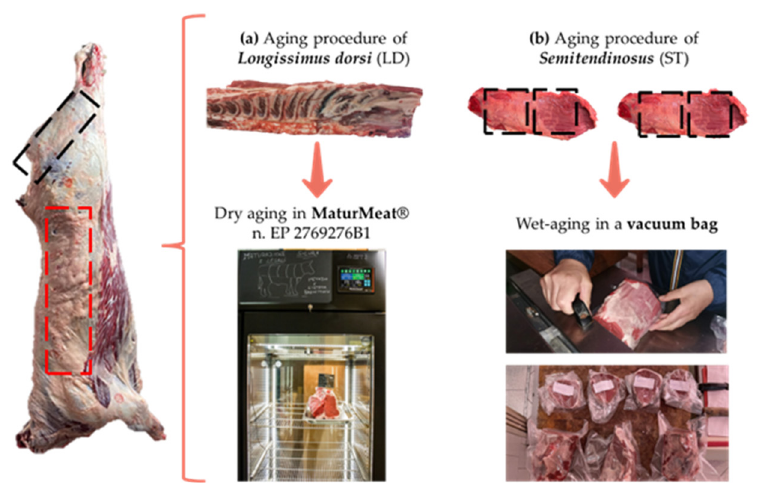
Figure 1. The schematic figures illustrate the dry ‐ aging ( a ) and wet ‐ aging ( b ) procedures of the bo ‐ vine muscles Longissimus dorsi (LD) and Semitendinosus ( ST). bovine muscles Longissimus dorsi (LD) and Semitendinosus (